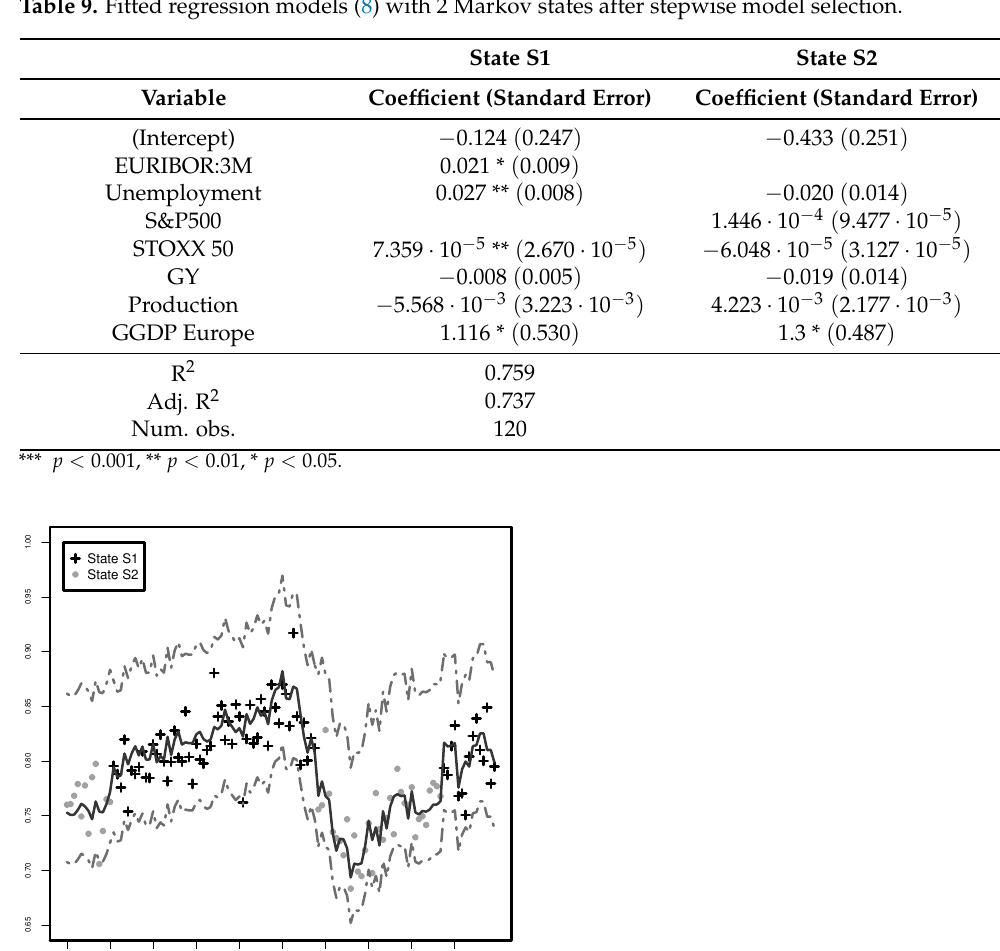
Table 9. Fitted regression models (8) with 2 Markov states after stepwise model selection.